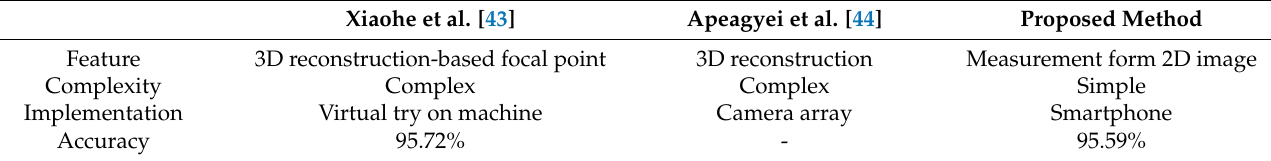
Table 2. Comparison of the proposed method with existing methods for body size measurements. Xiaohe et al. [43] Apeagyei et al.